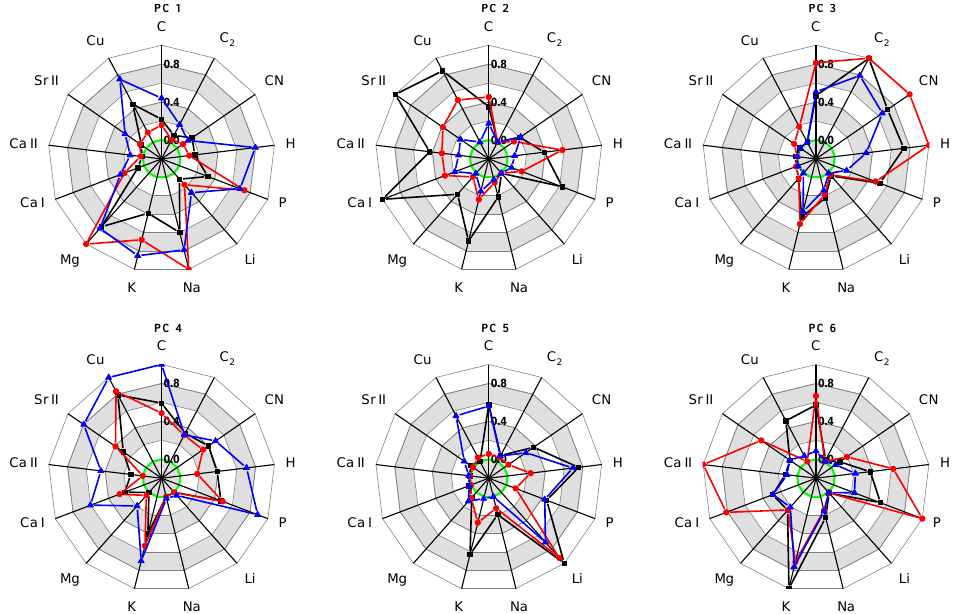
Figure 4. NMF decomposition of LIB spectra (without resonance lines). Shown are integrals of selected peaks on graphs of loadings, normalized to respective greatest absolute magnitudes among all the principal components. For wavelength positions of the peaks, please see the main text and supplementary tables. Black, red, and blue lines correspond to dark, medium-coloured, and light spots, respectively. The width of grey and white rings is 0.2.